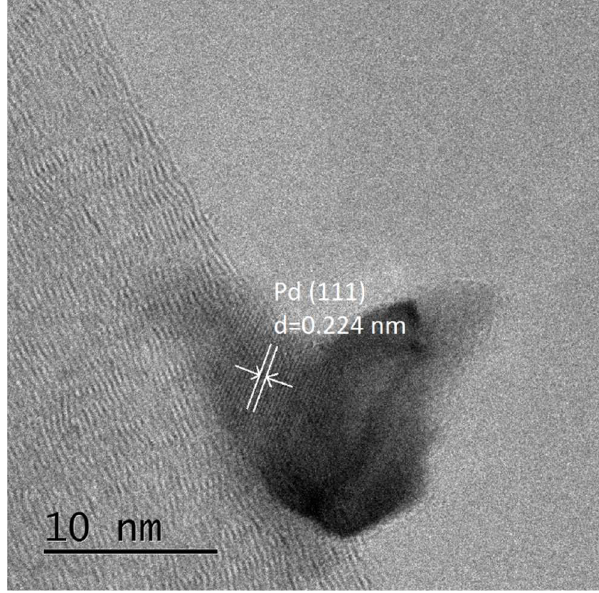
Figure 4. Bright field HRTEM image of Pd SI /CNF.